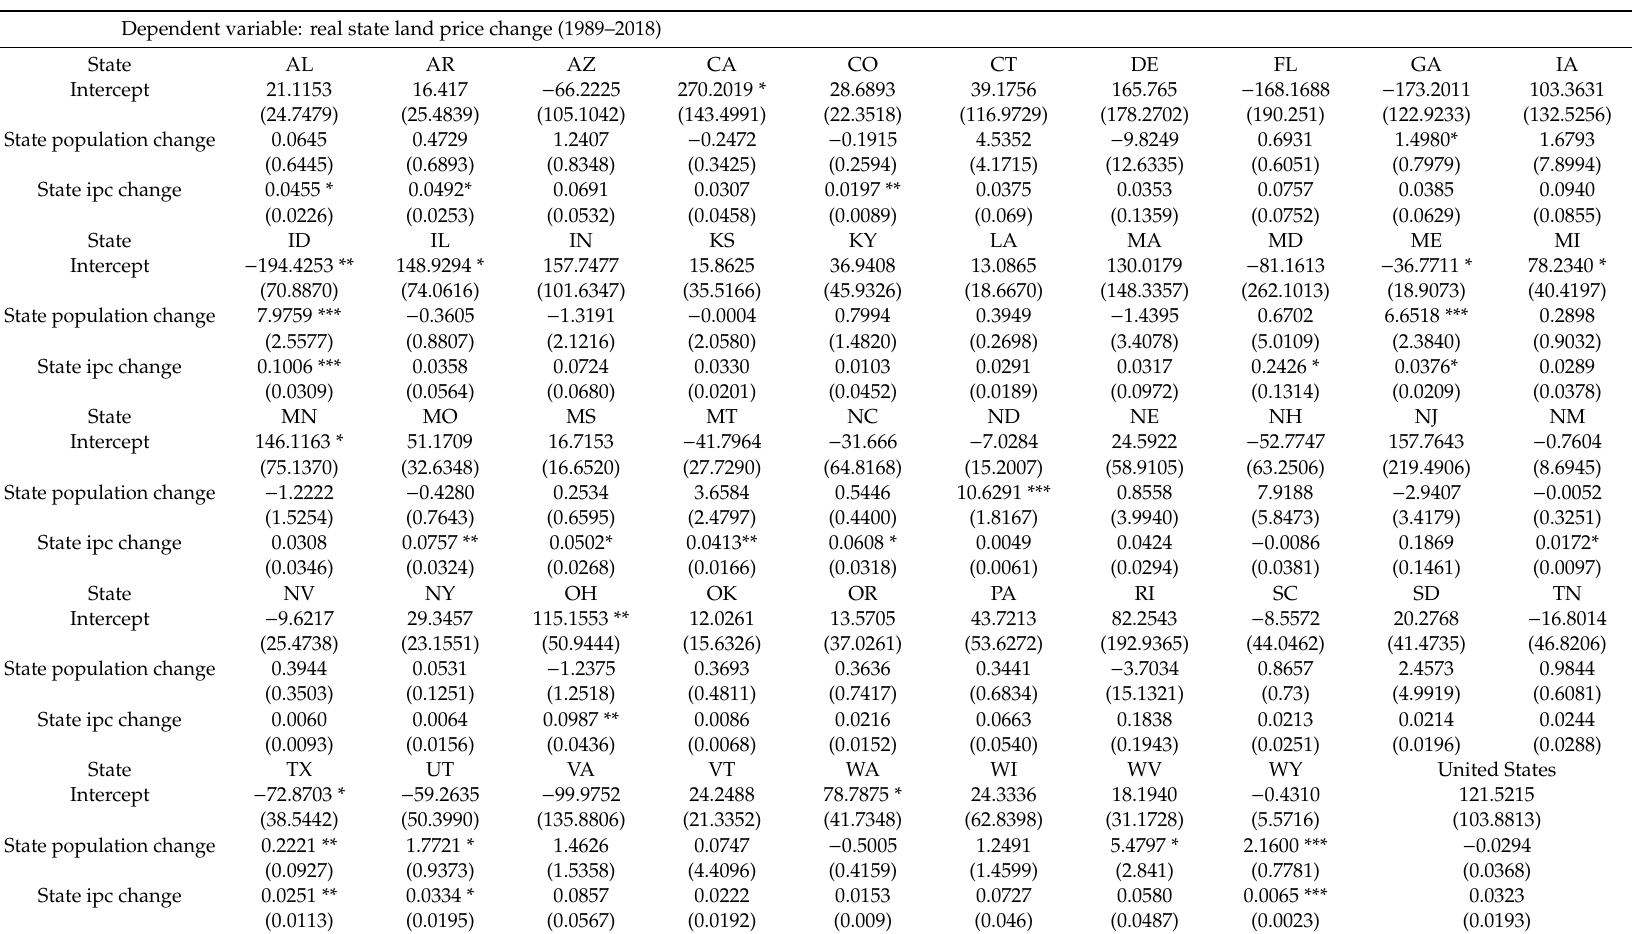
Table 6. The impact of state level population growth and income per capita growth on agriculture land price growth (1989–2018), real variables. Dependent variable: real state land price change